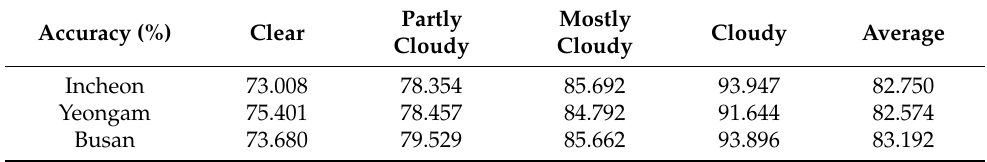
Table 5. The results of cloud movement verification by wind direction.